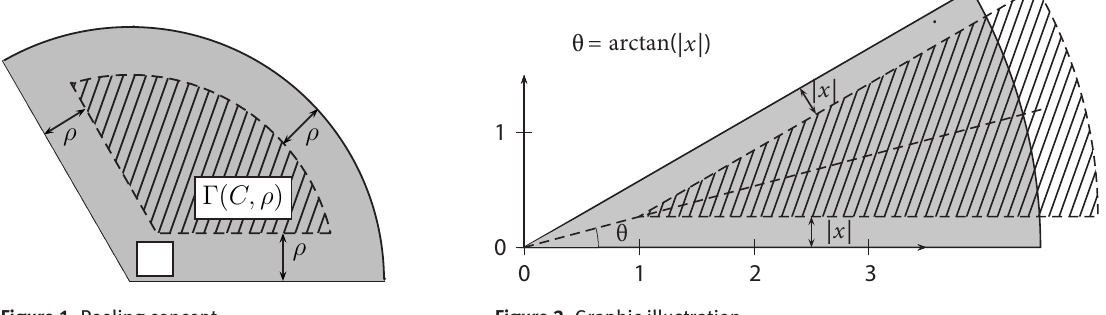
Figure 1. Peeling concept. Figure 2. Graphic